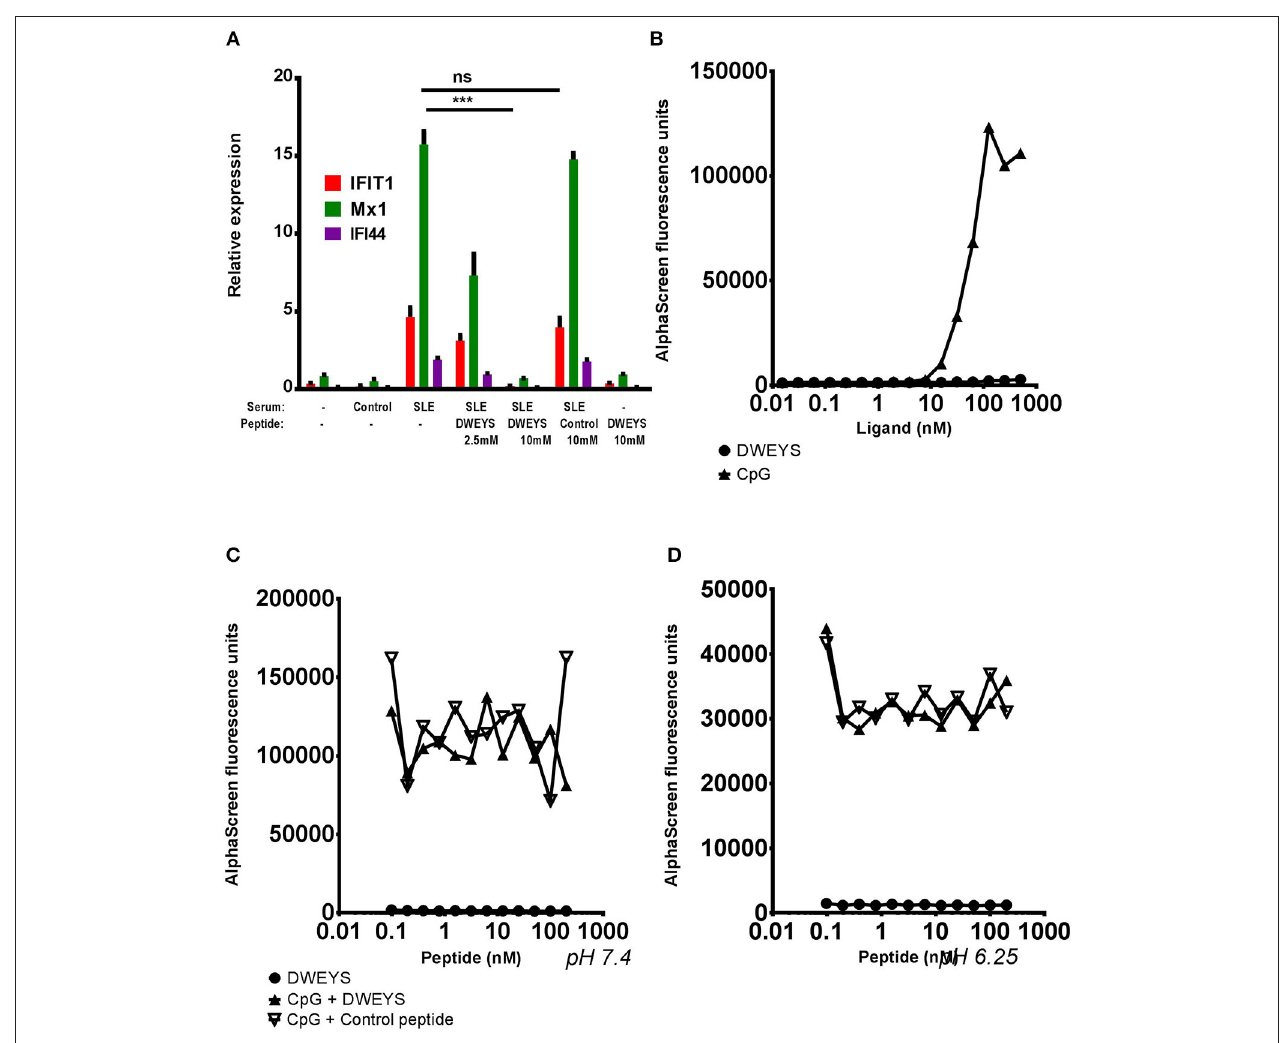
FIGURE 2 | DWEYS inhibits the transfer of the interferon signature by SLE serum but is not a TLR9 antagonist. (A) Primary human monocytes were incubated with SLE serum with or without DWEYS or with control peptide for 4h. lSG expression was evaluated by qPCR. Results indicate mean ± SD of three independent experiments. (B) Assessment of DWEYS and CpG oligonucleotides binding to TLR9. Labeled TLR9 was incubated with varying concentrations of CpG or DWEYS for 30 min in room temperature. Binding was assessed using an AlphaScreen assay as described in the methods section. (C,D) Inhibition assay. Labeled TLR9 and constant, binding concentration of CpG were incubated with different concentrations of DWEYS or a control peptide at neutral (pH 7.4, C ) or acidic (pH 6.25, D ) condition. Binding was assessed using an AlphaScreen assay as noted in the methods section. Results are representative of three independent experiments. *** p < 0.001, ns, not